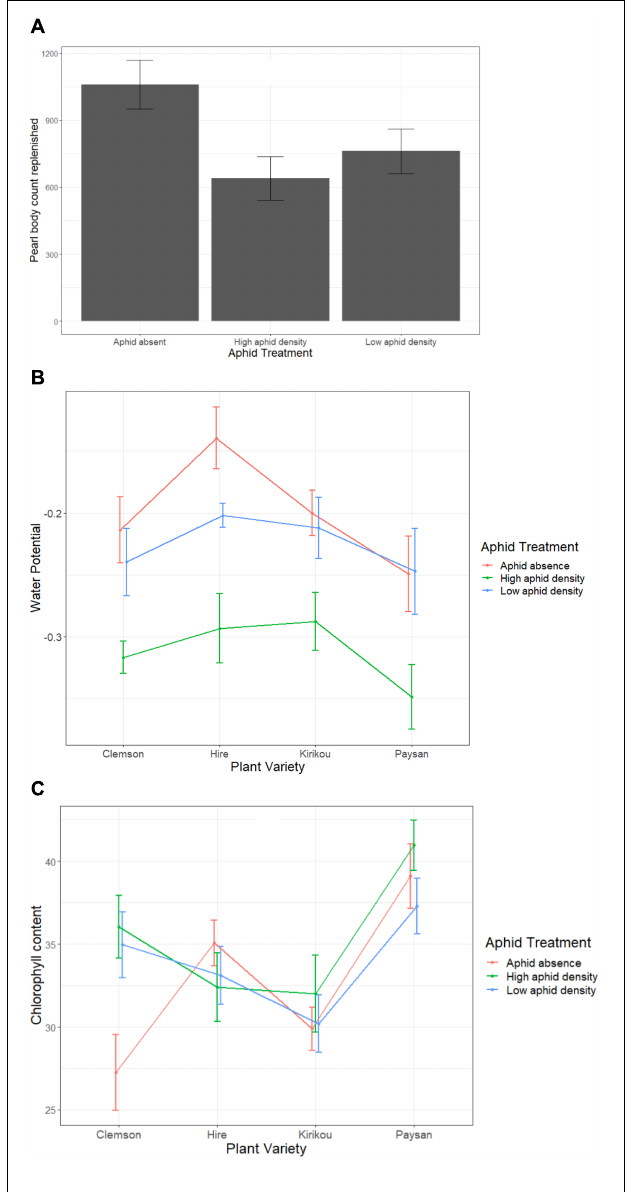
FIGURE 5 | (A) Variation in pearl body replenishment at different aphid densities, (B) Variation in water potential across okra varieties at different aphid densities, (C) Variation in total chlorophyll content across okra varieties at different aphid densities. Error bars represent ± 1